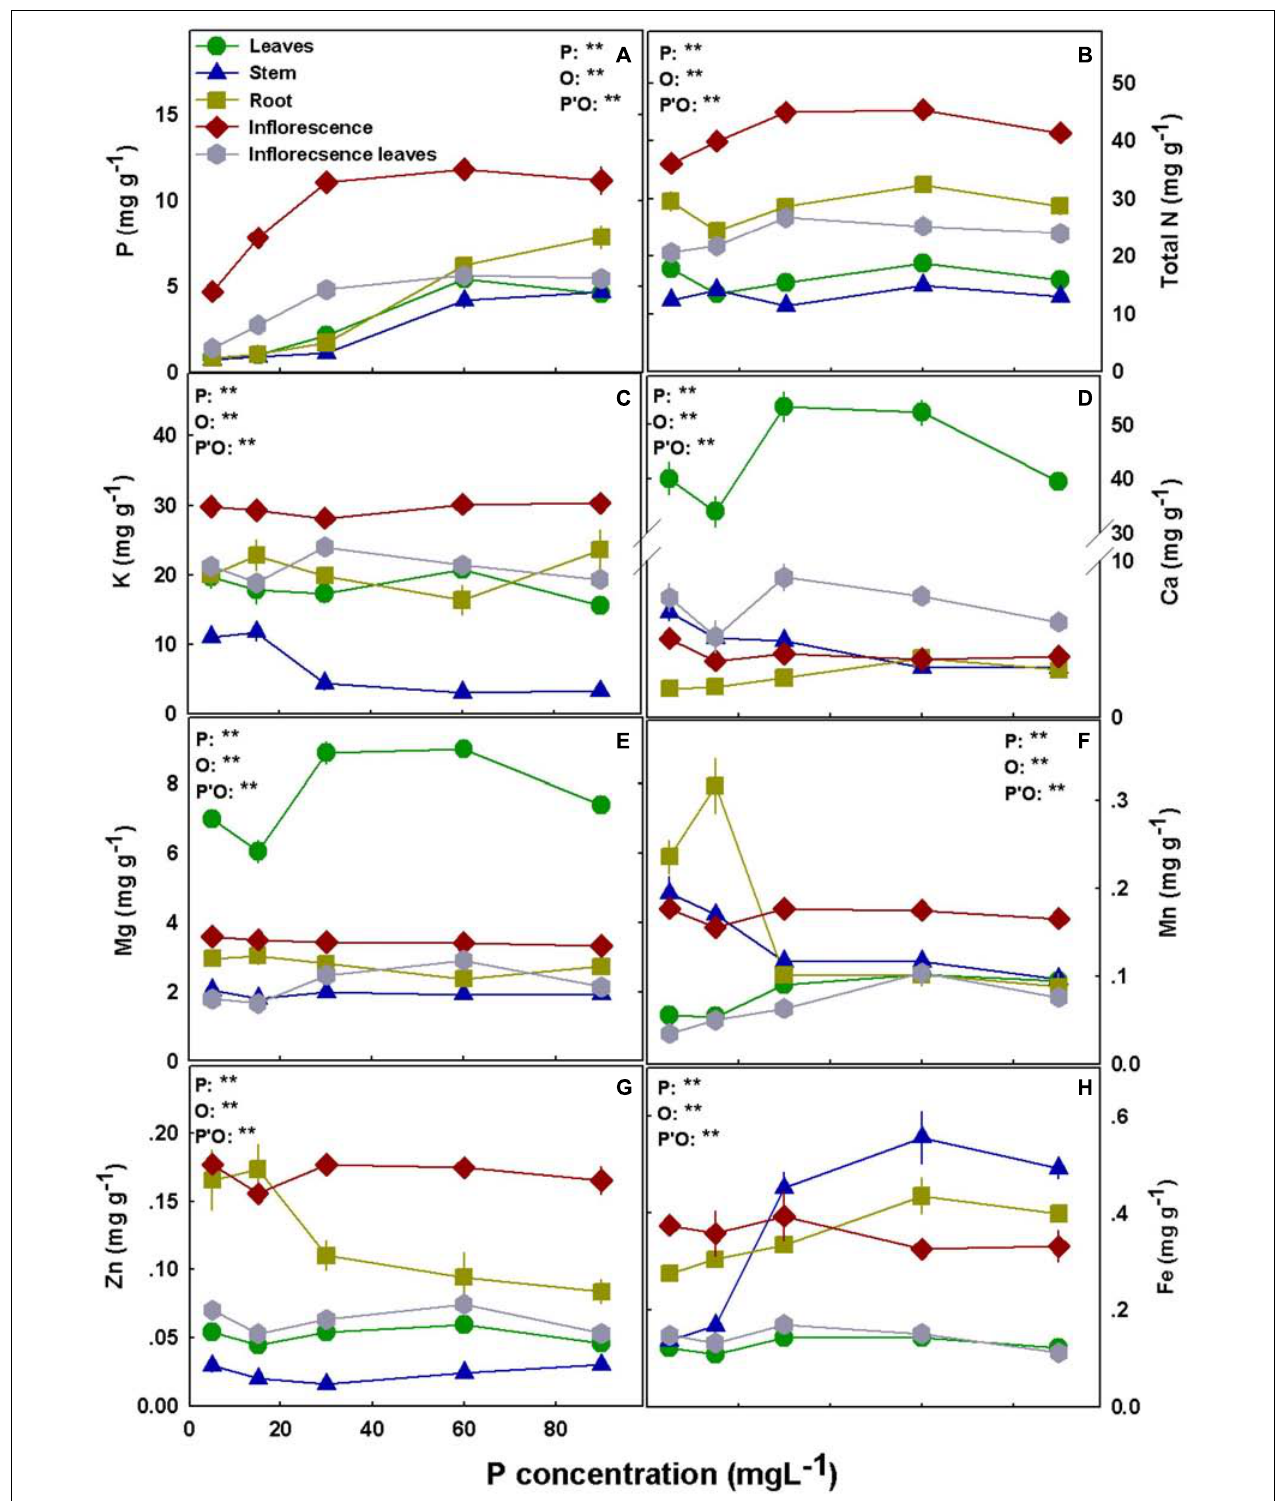
FIGURE 6 | Effect of P supply on nutrient concentrations in leaves, stems, roots and inflorescences in the medical cannabis cultivar DQ. P (A) , N (B) , K (C) , Ca (D) , Mg (E) , Mn (F) , Zn (G) , and Fe (H) . The presented data are averages ± SD ( n = 5); the concentrations are in mg g DW − 1 . Results of two-way ANOVA indicated as ** P < 0.05, F -test; NS, not significant P > 0.05, F -test. In the ANOVA results, P, phosphorus; O, organ; and P*O, the interaction between P and O.